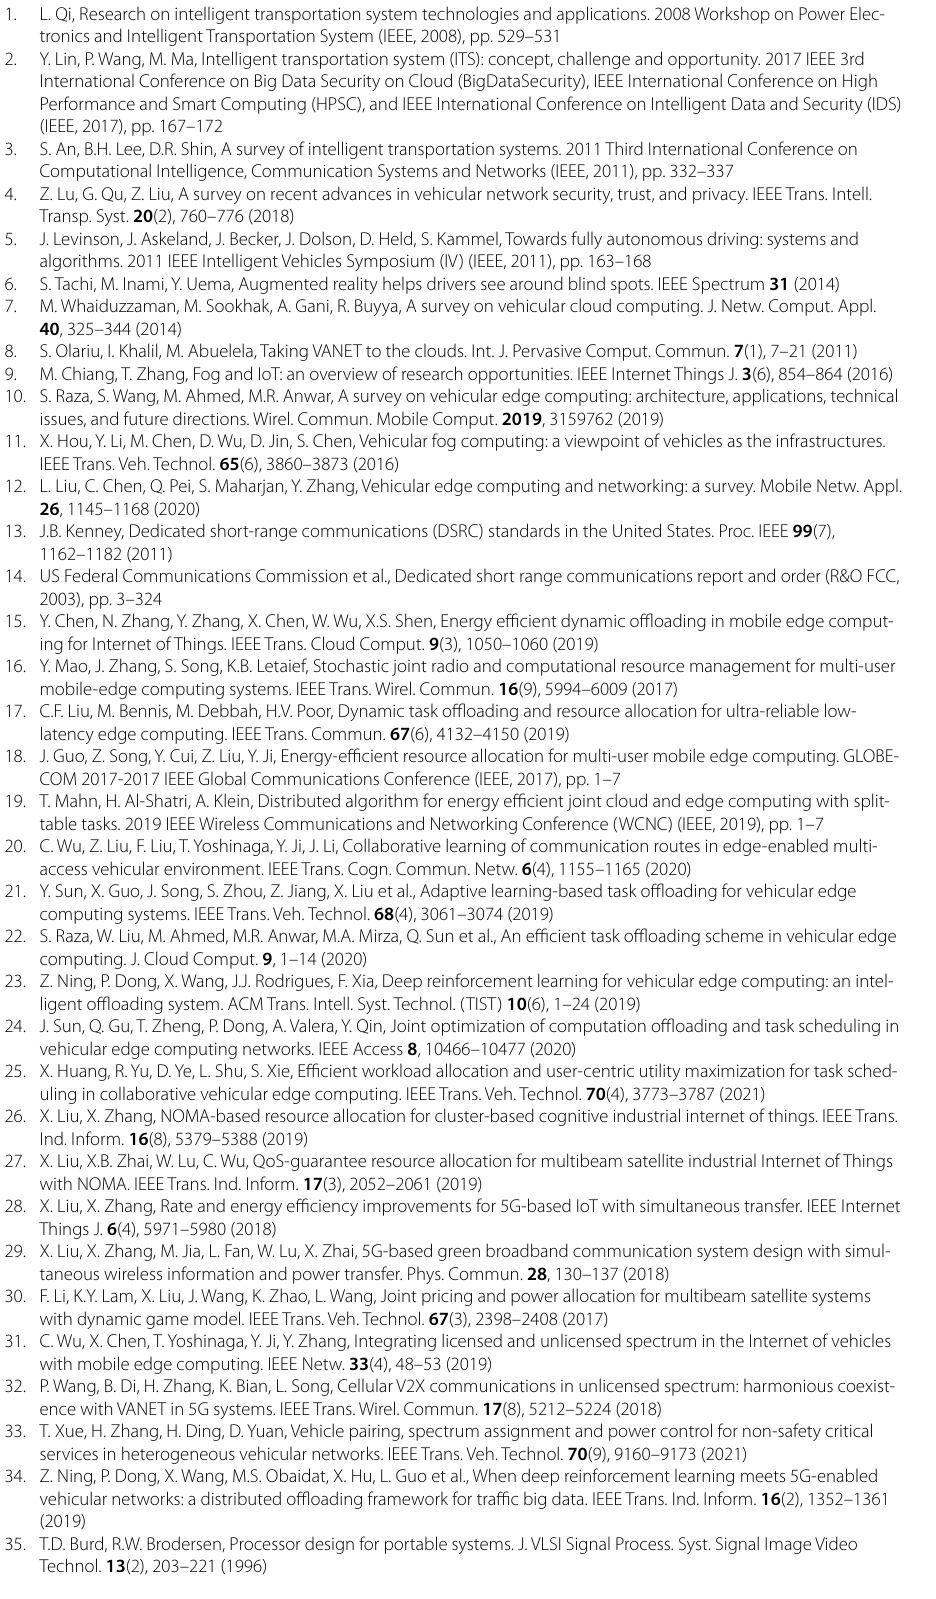
table tasks. 2019 IEEE Wireless Communications and Networking Conference (WCNC) (IEEE, 2019), pp. 1–7 20. C. Wu, Z. Liu, F. Liu, T. Yoshinaga, Y. Ji, J. Li, Collaborative learning of communication routes in edge-enabled